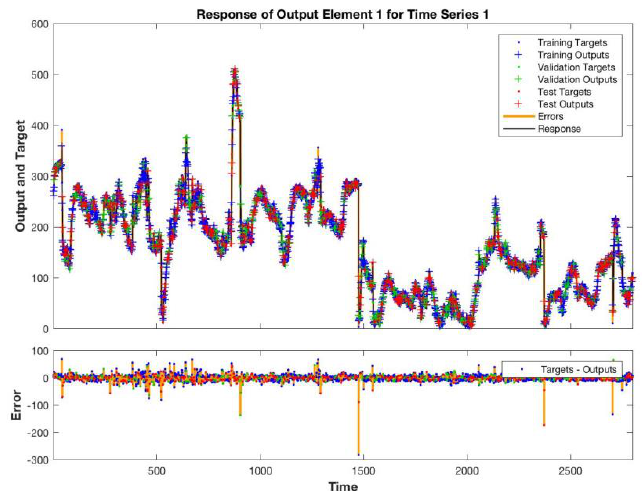
Figure 6. Estimated and measured total VOCs. The bottom plot shows the error between estimation and measured values.